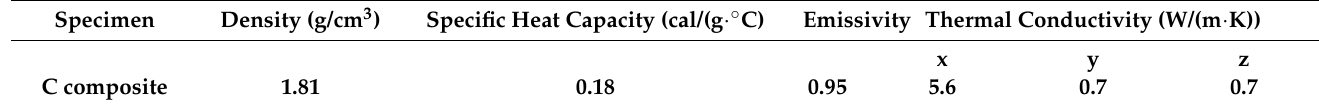
Figure 1. Geometric structure of carbon fiber composite material. Table 1. Thermophysical parameters of carbon ‐ fiber ‐ reinforced composites.